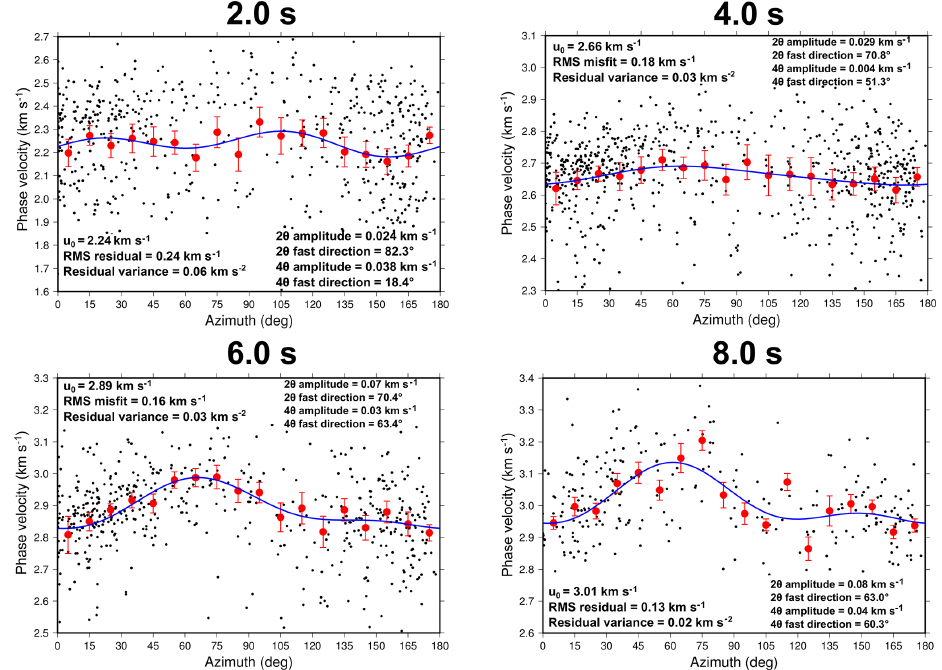
Figure 8. Azimuthal variation of Rayleigh wave phase velocities with propagation azimuth (from north). Black dots indicate the raw phase velocity measurements, and large red dots show the average of the phase velocities within 5 ◦ azimuth bins and the corresponding standard error of the mean for the bin. The blue line is the best-fitting curve (Eq. 4) to the binned data (red dots). u 0 is the average (isotropic) phase velocity. We show the root mean square misfit of the blue curve to the phase velocity measurements, as well as the variance of the residuals. We indicate the 2 θ and 4 θ amplitudes and fast directions that correspond to the blue curve. The azimuthal distribution of ray paths used in this analysis is shown in Supplement Fig.